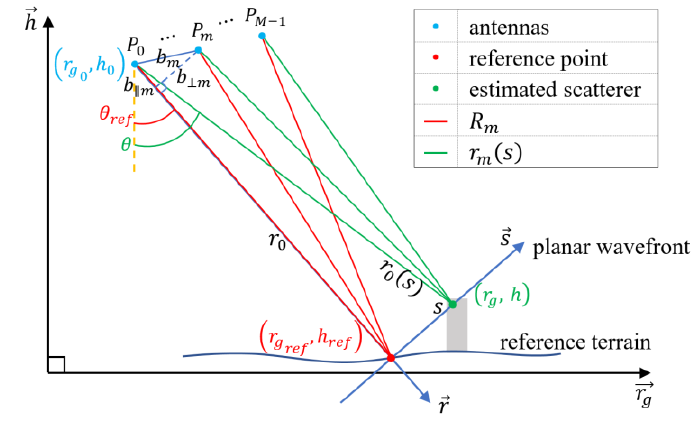
Figure 2. TomoSAR imaging geometry based on a planar wavefront.